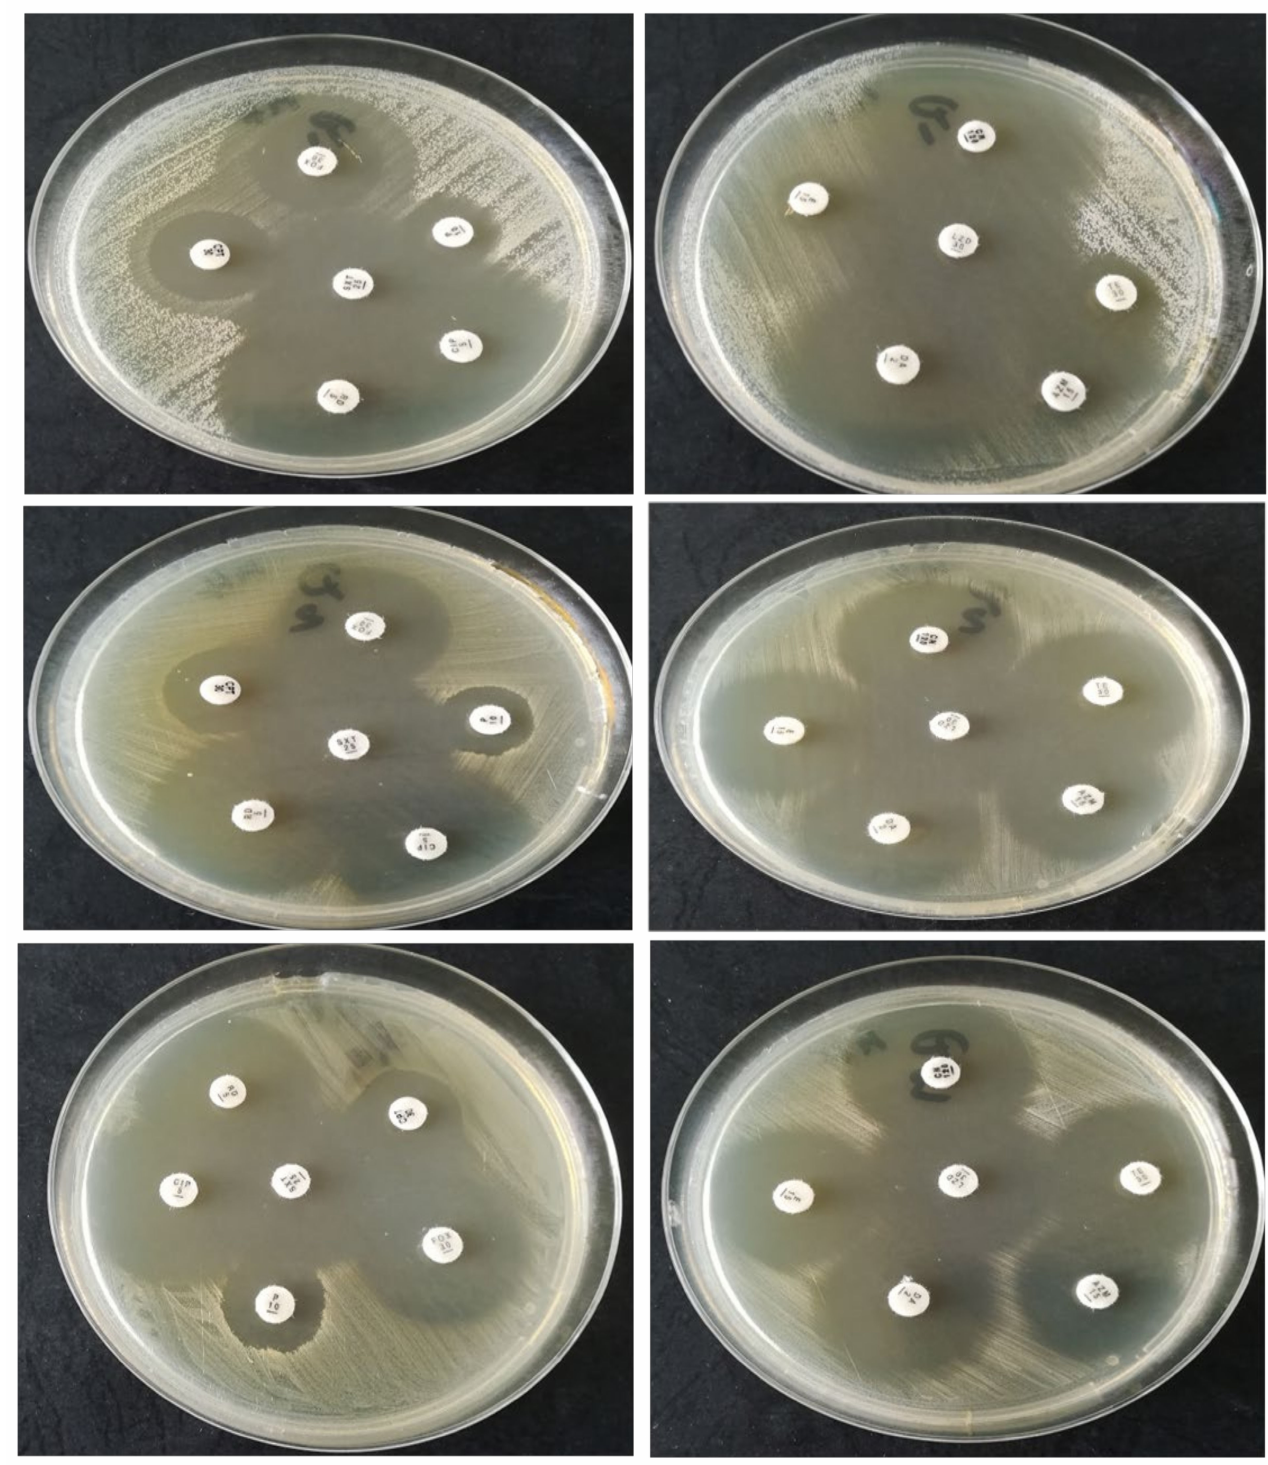
Figure 3. Antibiogram of analyzed strains P1— S. epidermidis (first row of images), P2— S. aureus (second row of images), P3— S. aureus (the third row of